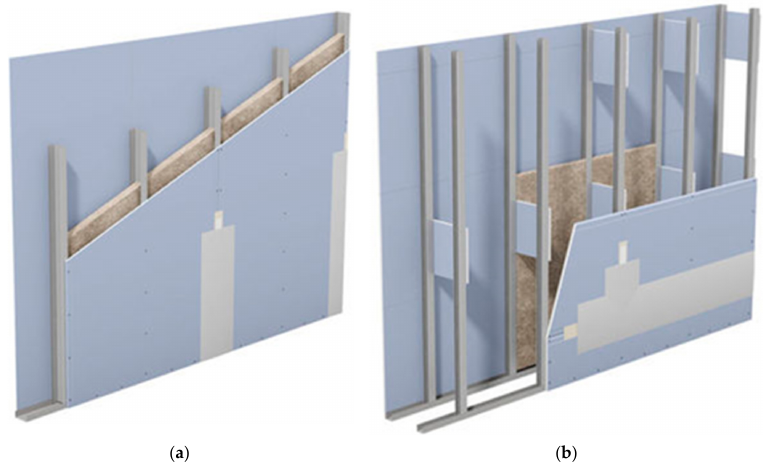
Figure 3. Drywall non-structural architectural components: partitions. ( a ) Partition with single layer of studs; ( b ) partition with double layer of studs.